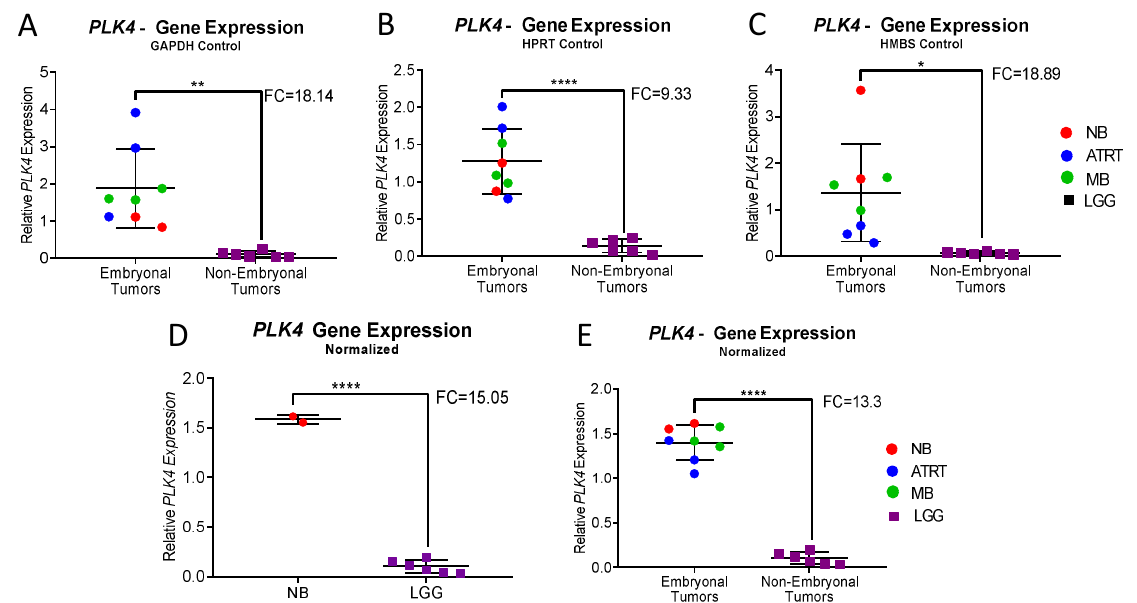
Figure 3. qRT-PCR Expression Analysis of CNS-NB, ATRT, MB and LGG. ( A – C ) Relative PLK4 expression in CNS-NB, embryonal and non-embryonal pediatric brain tumors measured by qRT-PCR normalized to the endogenous controls GAPDH , HPRT and HMBS respectively, compared to LGG. ( D ) Relative PLK4 expression in CNS-NB when normalized to all three endogenous controls compared to LGG. ( E ) Relative PLK4 expression in embryonal tumors compared to non-embryonal tumors, normalized to all three endogenous controls. Fold changes and p-values were compared to non-embryonal pediatric brain tumors (unpaired t-tests, * p < 0.1, ** p < 0.01, **** p < 0.0001). Table 1. Relative PLK4 expression in NB, ATRT, MB and LGG. Relative PLK4 expression measured by qRT-PCR, calculated against 3 different endogenous controls individually and normalized together. Normalized